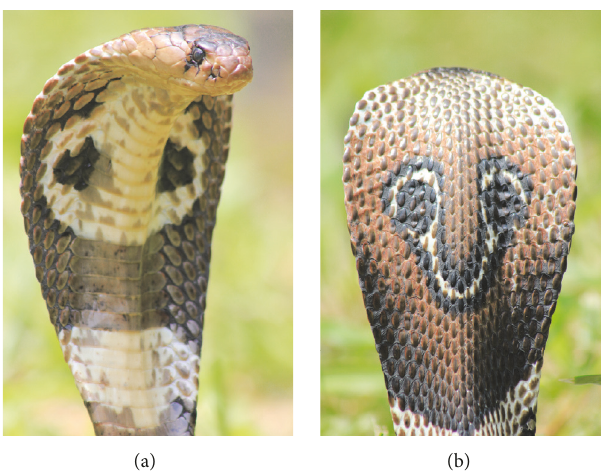
Figure 1: Spectacled cobra ( Naja naja ); (a) distinct hood and (b) spectacle pattern on the